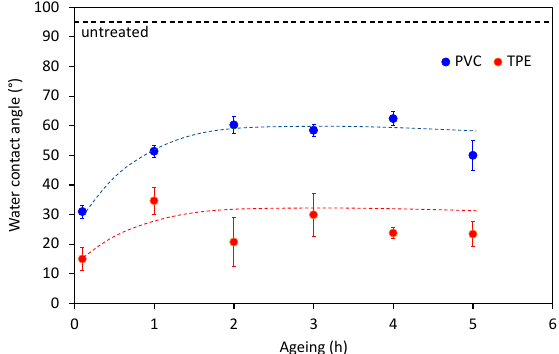
Figure 3. Aging of the surface of plasma-treated catheters.